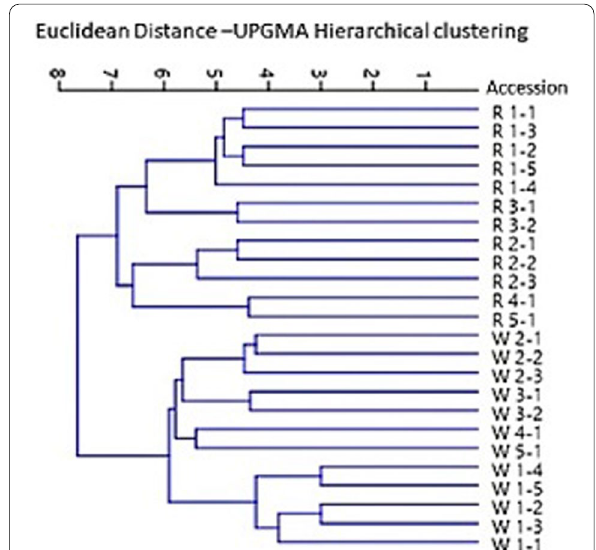
Fig. 3 Euclidean UPGMA distance tree constructed using the PAST software differentiating all wild accessions from their regenerated